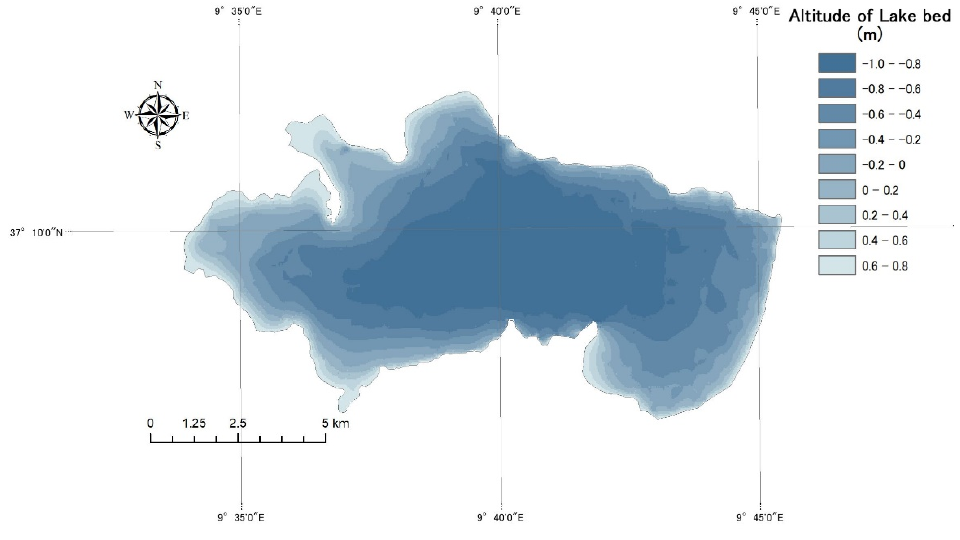
Figure 2. Bathymetry of Ichkeul Lake.